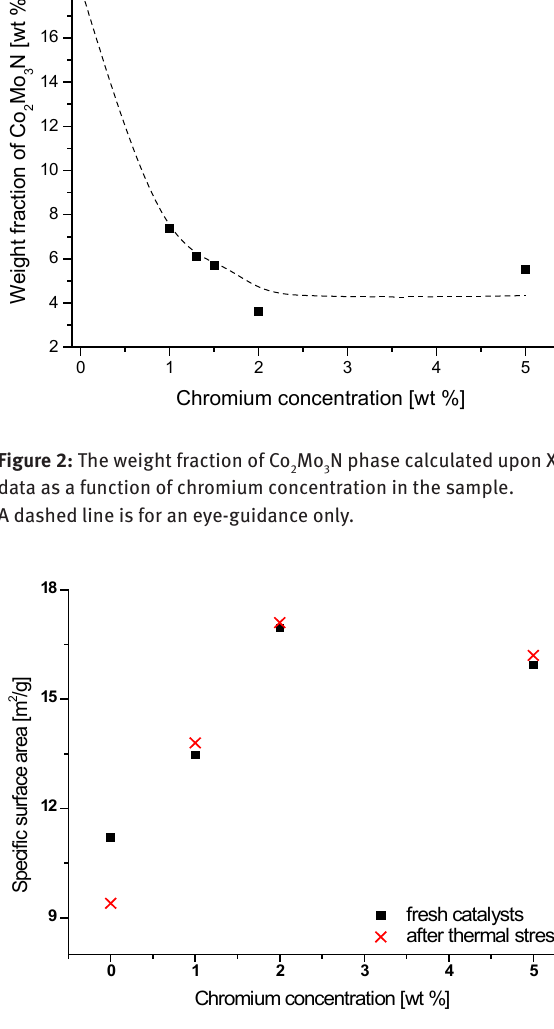
Figure 3: The specific surface area of the catalysts as a function of chromium concentration in the sample.